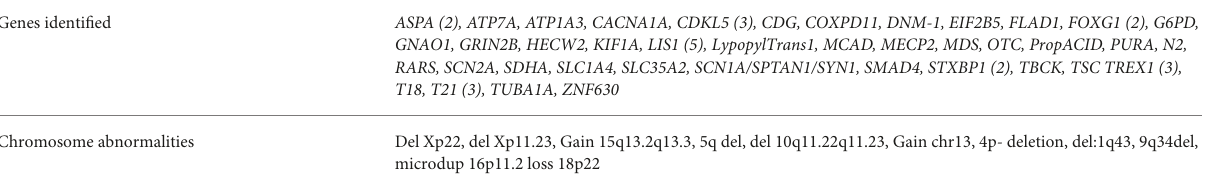
TABLE 3 List of abnormal genes and/or chromosome rearrangements identified in the CVI cohort. Genes